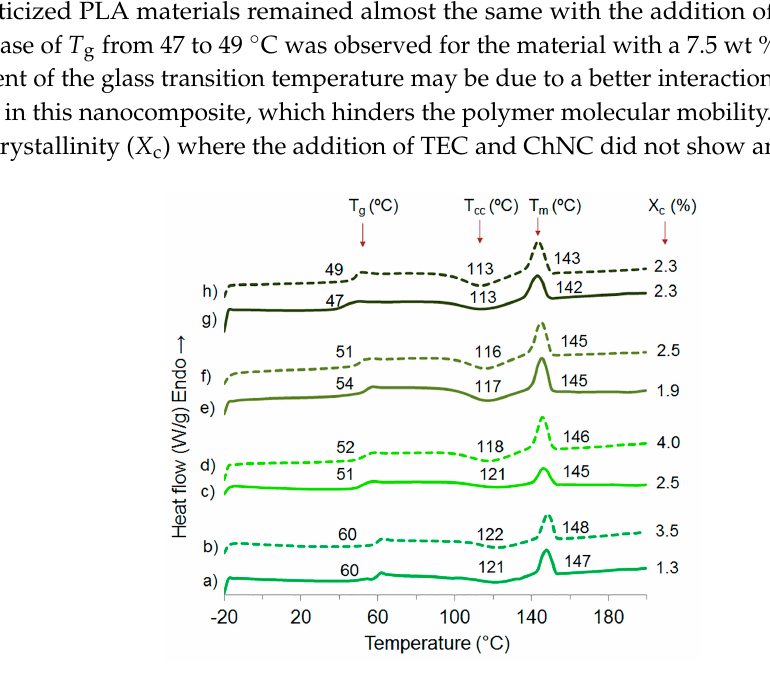
Figure 8. DSC scans of: ( a ) extruded PLA with water and ethanol; ( b ) PLA-ChNC; ( c ) PLA-TEC2.5; ( d ) PLA-TEC2.5-ChNC; ( e ) PLA-TEC5.0; ( f ) PLA-TEC5.0-ChNC; ( g ) PLA-TEC7.5; and ( h ) PLA-TEC7.5-ChNC.